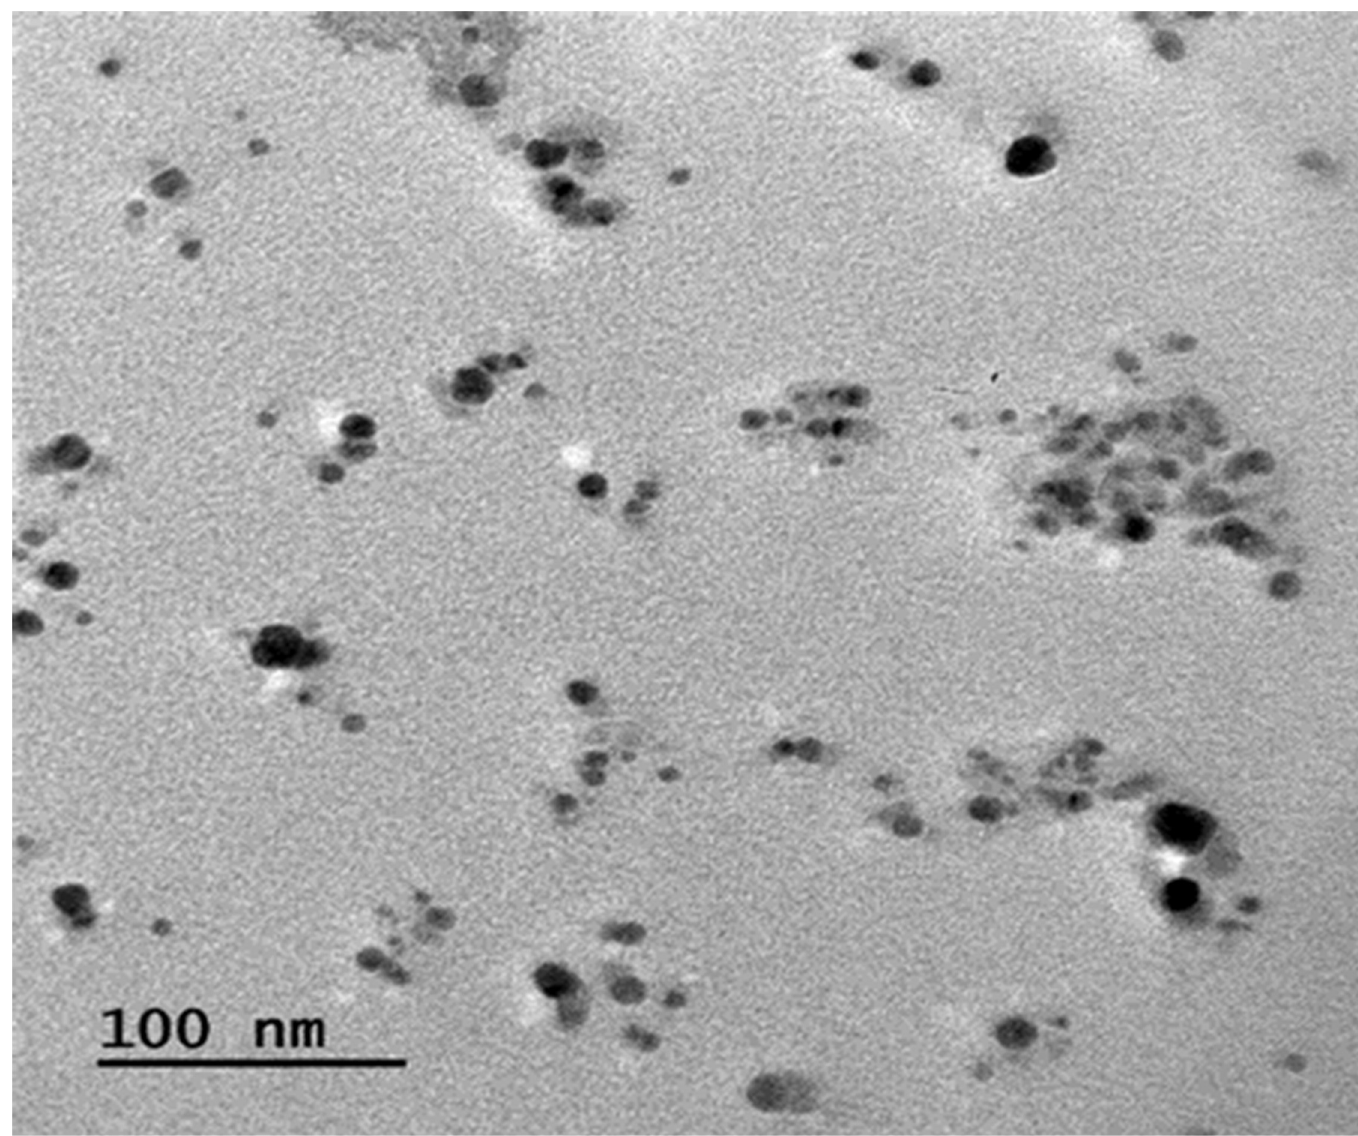
Fig 7. TEM image of green synthesized AgNPs from